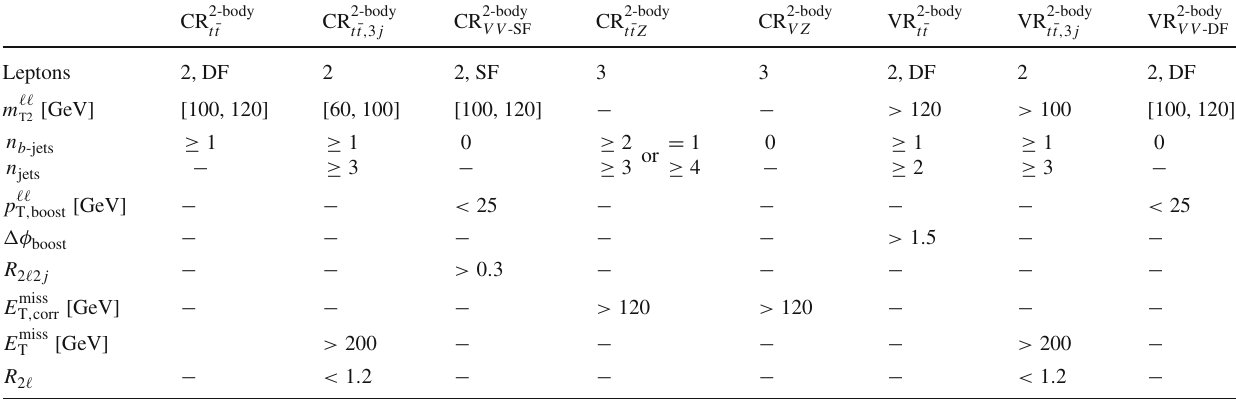
Table 6 Two-body selection control and validation regions definition. The common selection defined in Sect. 4 also applies to all regions except CR 2-body and CR 2-body , which require three leptons including one same-flavour opposite-charge pair with | m (cid:3)(cid:3) − m Z | < 20 VZ t ¯ tZ